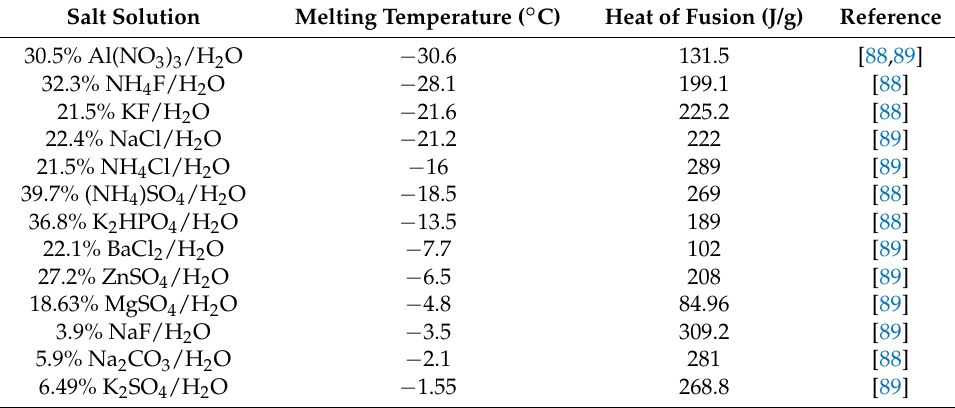
Table 3. Melting temperatures and heat of fusion of salt solutions for refrigeration